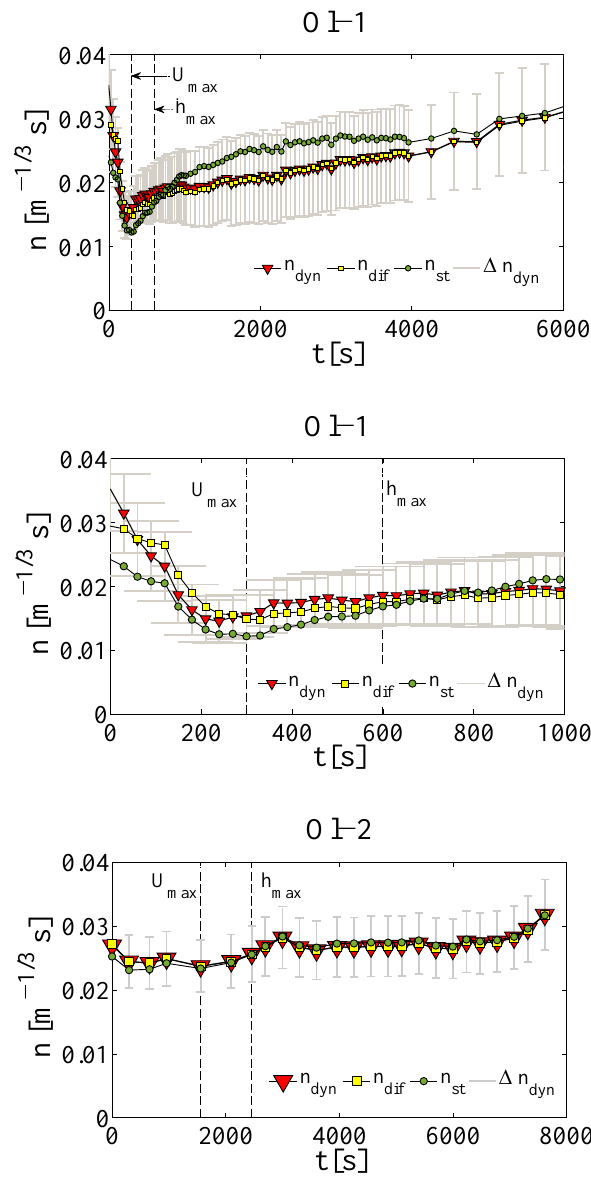
Figure 11. Comparison of n evaluated by formulae for dynamic n dyn , diffusive wave n dif and steady uniform flow n st with uncer- tainty bounds (cid:49)n dyn for experimental flood waves in the Olszanka watercourse. Middle panel shows an enlargement of the rising limb of the wave for